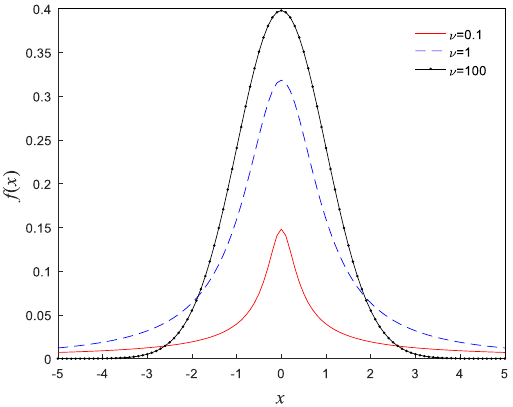
Figure 3. The Student’s t distribution for various degrees of freedom.